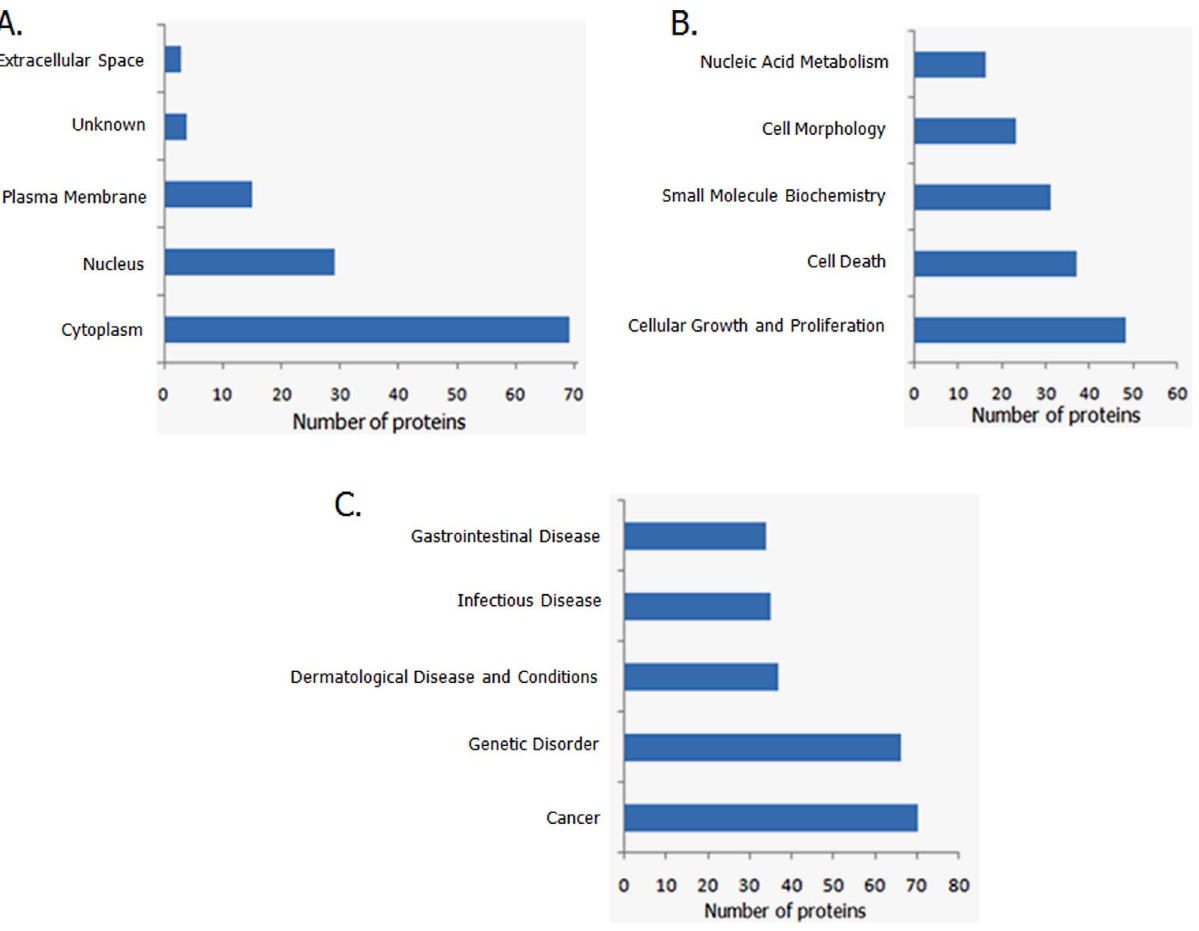
Figure 1. Subcellular location, molecular functions and disease classifications of differentially regulated proteins. Ingenuity knowledge base analysis was used to determine the sub-cellular localization, molecular and biological functions and disease processes that are associated with the proteins that are differentially regulated between PC3-N2 and PC3-ML2 cells. The numbers of proteins are shown in the x-axis and in Tables S2 and